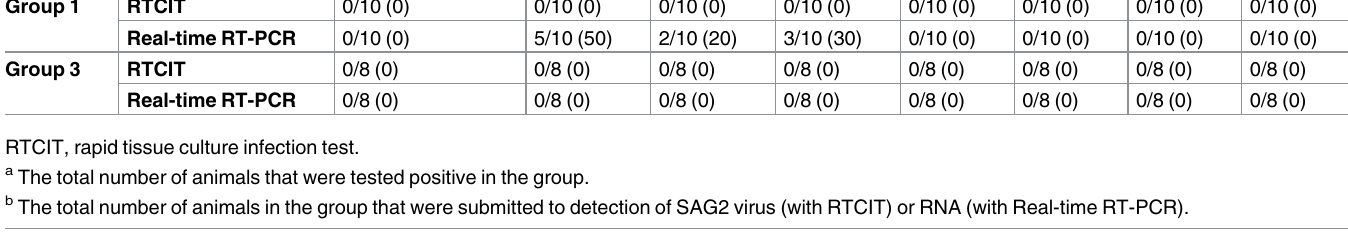
on D14 (geometric mean = 0.49 IU/ml, SD = 2.60) ranging from 0.03 to 8.69 IU/ml, but only 8 out of 15 ferret badgers presented a rabies neutralising antibody level that exceeded the positiv- ity threshold (Fig 1B and S1 Table). Antibody titres peaked on D30 (geometric mean = 0.55 IU/ml, SD = 4.11), with 10 out of 15 animals having titres above 0.5 IU/ml. Subsequently, anti- body titres declined slightly on D45 (geometric mean = 0.48 IU/ml, SD = 19.2) and D60